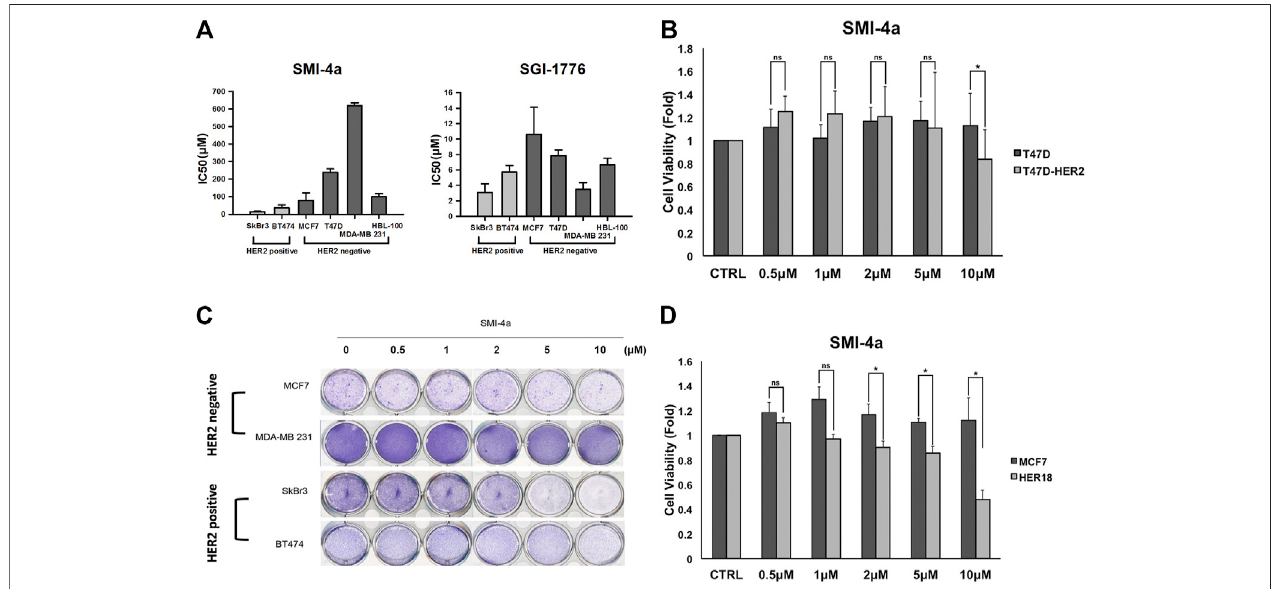
FIGURE 3 | HER2-expressing breast cancer cells were more sensitive to Pim1 inhibitor-induced inhibition of cell viability. (A) The IC50 of SMI-4a and SGI-1776 in SkBr3,BT474,MCF7,T47D,HBL-100,andMDA-MB-231cellswasdeterminedbyMTTassay. (B) HER2expressionvectororemptyvectorwastransientlytransfected intoHER2-positiveSkBr3orBT474cellsfor2 days,followedbythedeterminationofcellviabilityinresponsetoSMI-4ainMTTassay. (C) TheeffectsofSMI-4aonthecell viabilities of MCF7, HER18, and HER2-transfected T47D cells were determined in MTT assay. Results were expressed as mean ± S.E.M. of three independent experiments.*: p < 0.05;**: p < 0.01ascompared withcontrolgroup. (D) MCF7,HER18,T47DandT47D-HER2cellsweretreatedwithSMI-4aat10 μ Mandsubjected to clonogenic assay for 14 days. Cell viability was determined by crystal violet